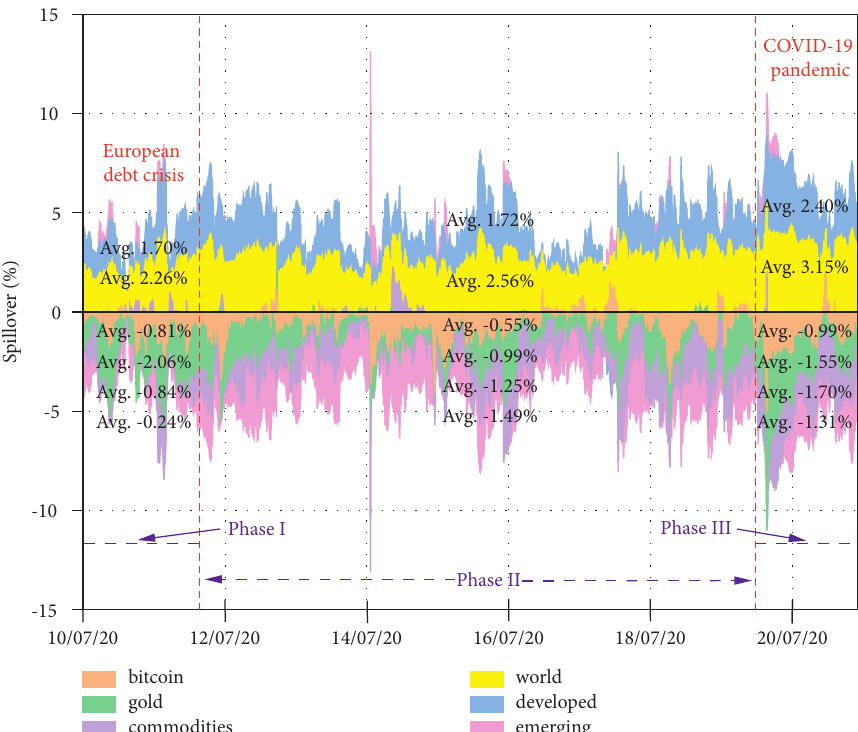
Figure 2: Dynamic return net total directional spillover for TVP-VAR. The different color areas define the accumulation of net total directional spillover. The net spillover of returns plotted here is computed by equation (12), which is defined as the difference in total directional connectedness to others and from others. All abbreviations are as follows: bitcoin, gold, and commodities indices (commodities); the world stock index (world); the developed stock index (developed); and the emerging stock index (emerging). The sample period for returns is from July 20, 2020, to June 23,